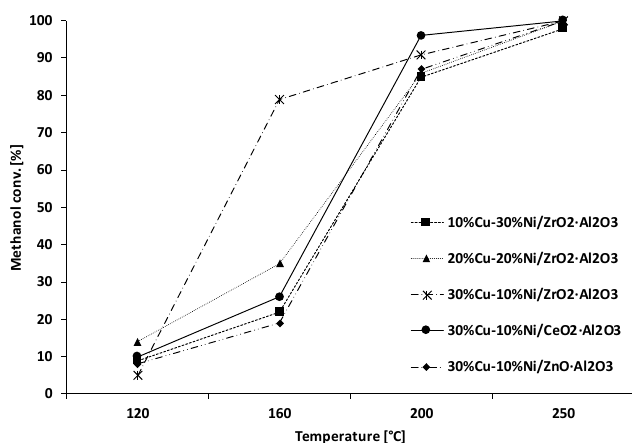
Figure 1. The influence of the reaction temperature on the methanol conversion in the oxidative steam reforming of methanol (OSRM) process.